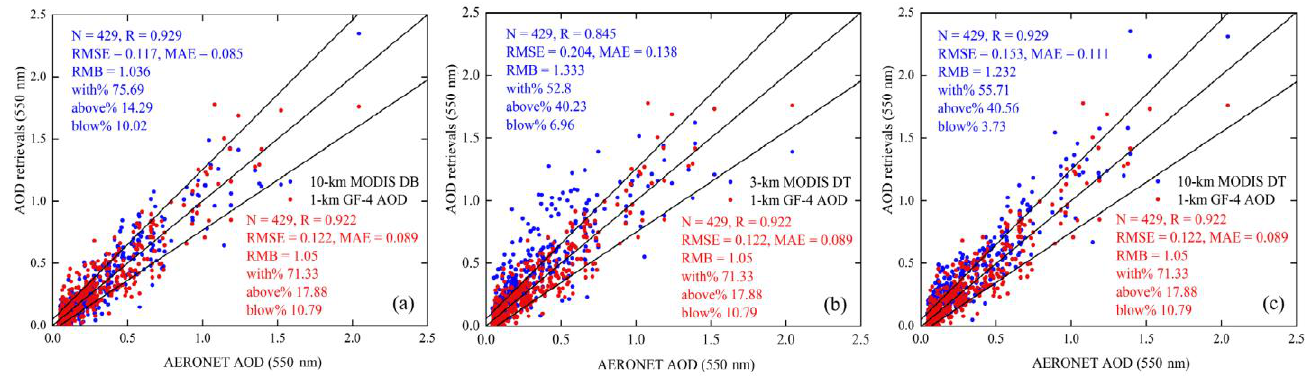
Figure 3. Comparison of our 1 km AOD retrievals (red dots) matched with ( a ) MOD04 10 km DB, ( b ) 3 km DT, ( c ) 10 km DT retrievals as a function of AERONET AOD measurements at all sites in Eastern China from 2017 to 2018.